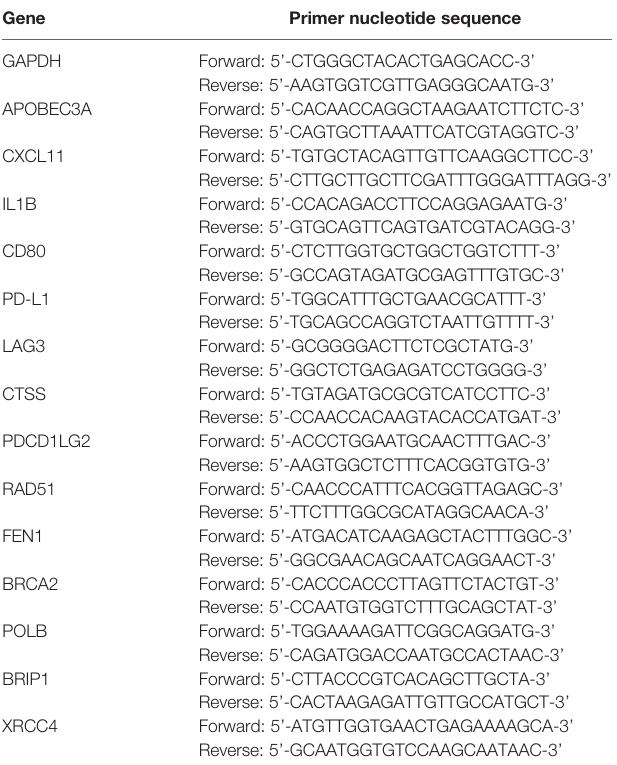
TABLE 1 | Primer nucleotide sequence of this study. Gene Primer nucleotide